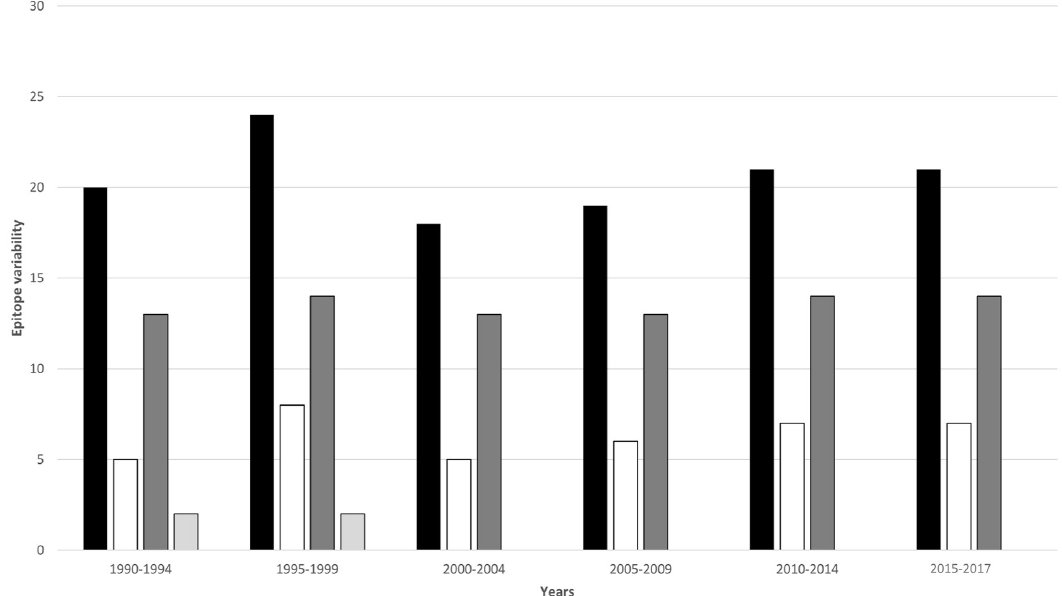
Fig 6. Divergence and evolution of HIV-1 CRF01_AE gag CTL epitopes. Bar chart summarizing epitope data for each year group. Black bars show the total number of gag epitopes observed for each year group, white bars represent epitope variability (total number of mutations in all epitope sequences in the year group/total number of epitopes in a year group), dark grey bars indicate intermittently recurring epitopes, and light grey bars indicate novel epitopes that were observed in one year group only.